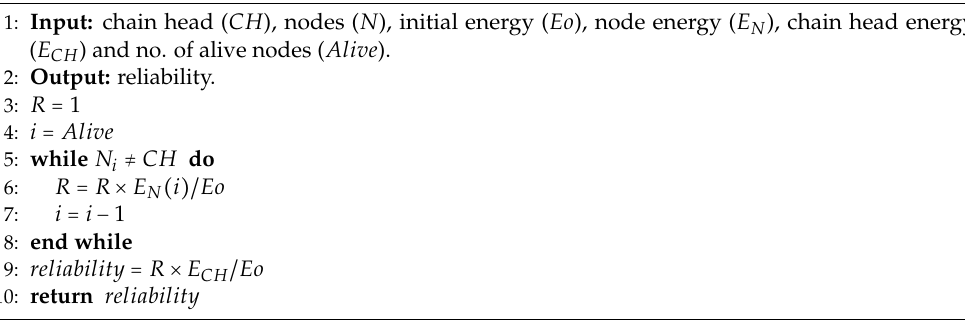
Algorithm 1 Calculate reliability of SD-Chain.